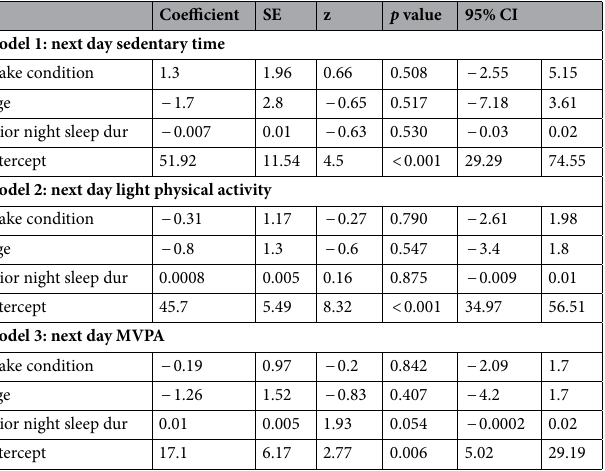
Table 4. Repeated measures mixed model results for models exploring effects of nap- and wake-promotion on next day movement behaviors. SE standard error, CI confidence interval, MVPA moderate- to vigorous- intensity physical